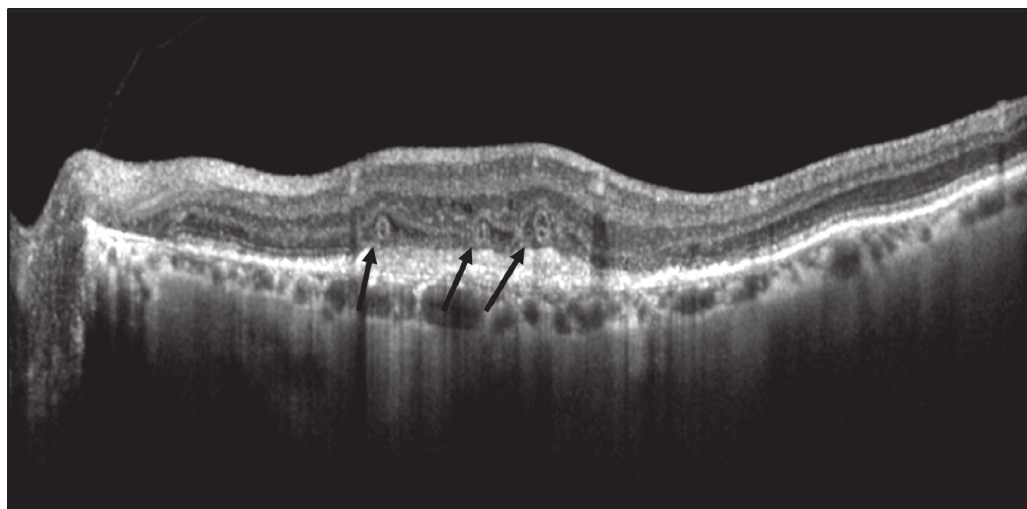
Figure 4: Structural OCT biomarkers: outer retinal tubulations (black